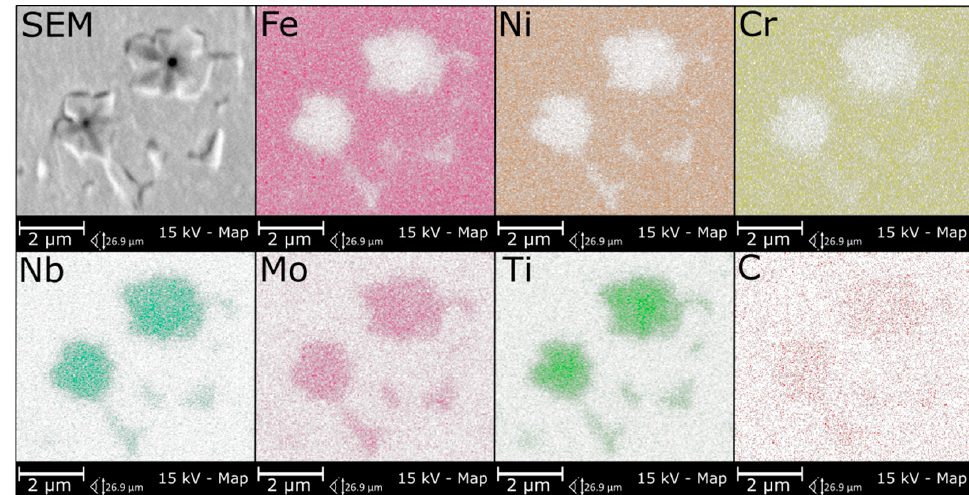
Figure 8. The EDS analysis results of the secondary phases in the matrix, representative coating.